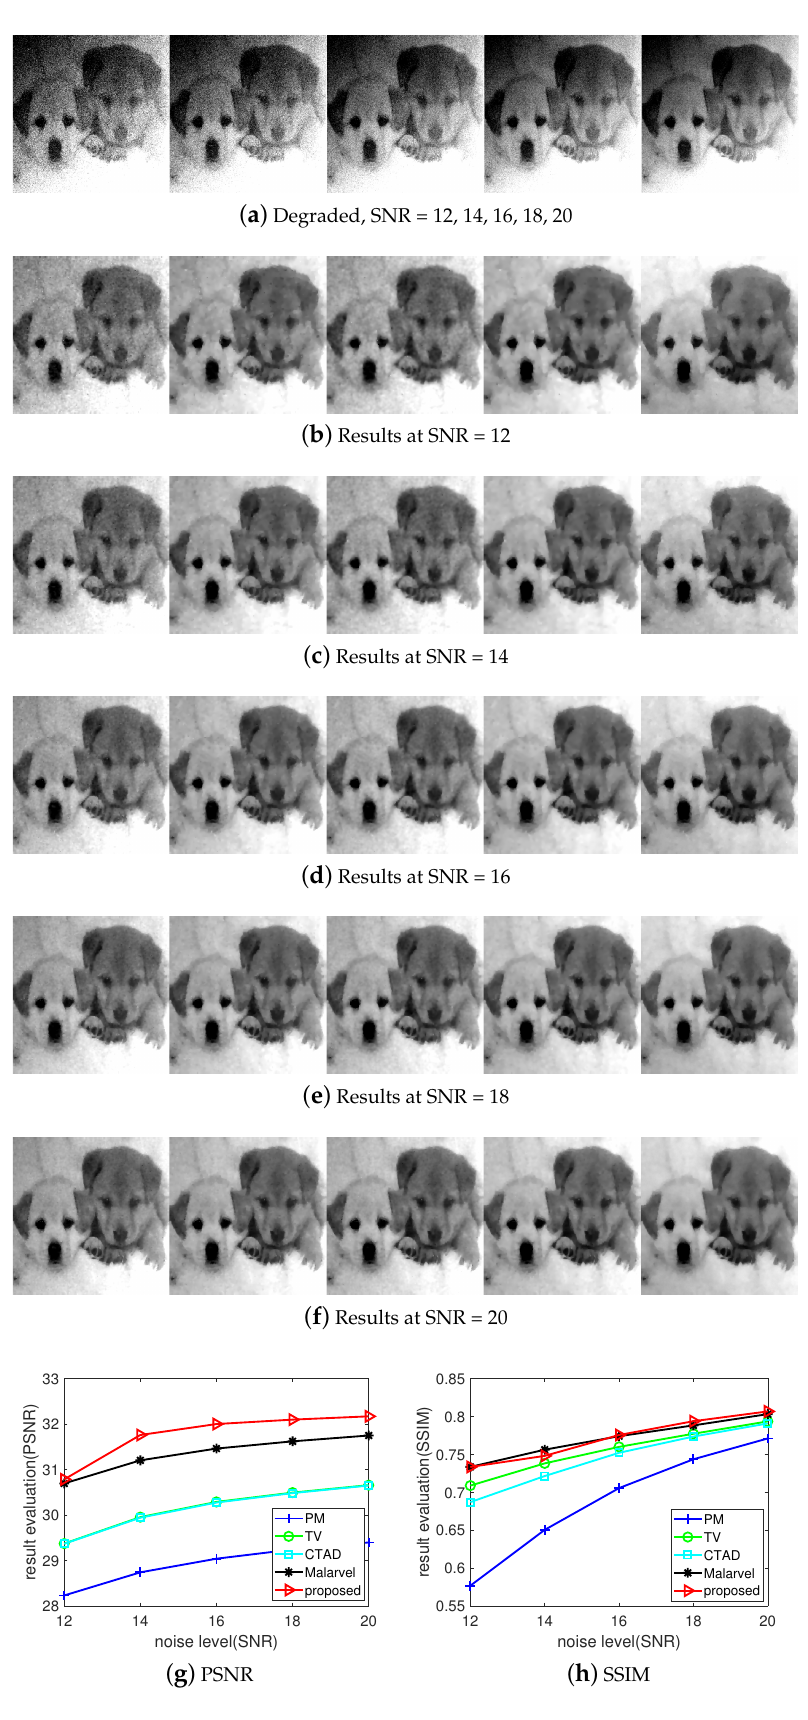
Figure 8. Results of dogs image in Experiment